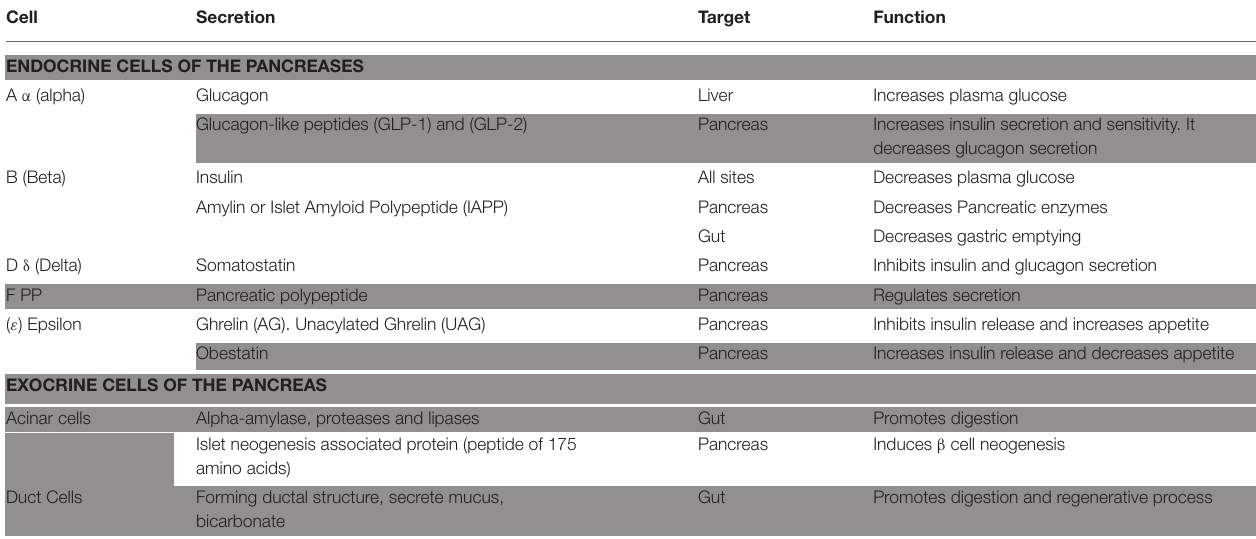
TABLE 1 | Pancreatic cell populations and functions.